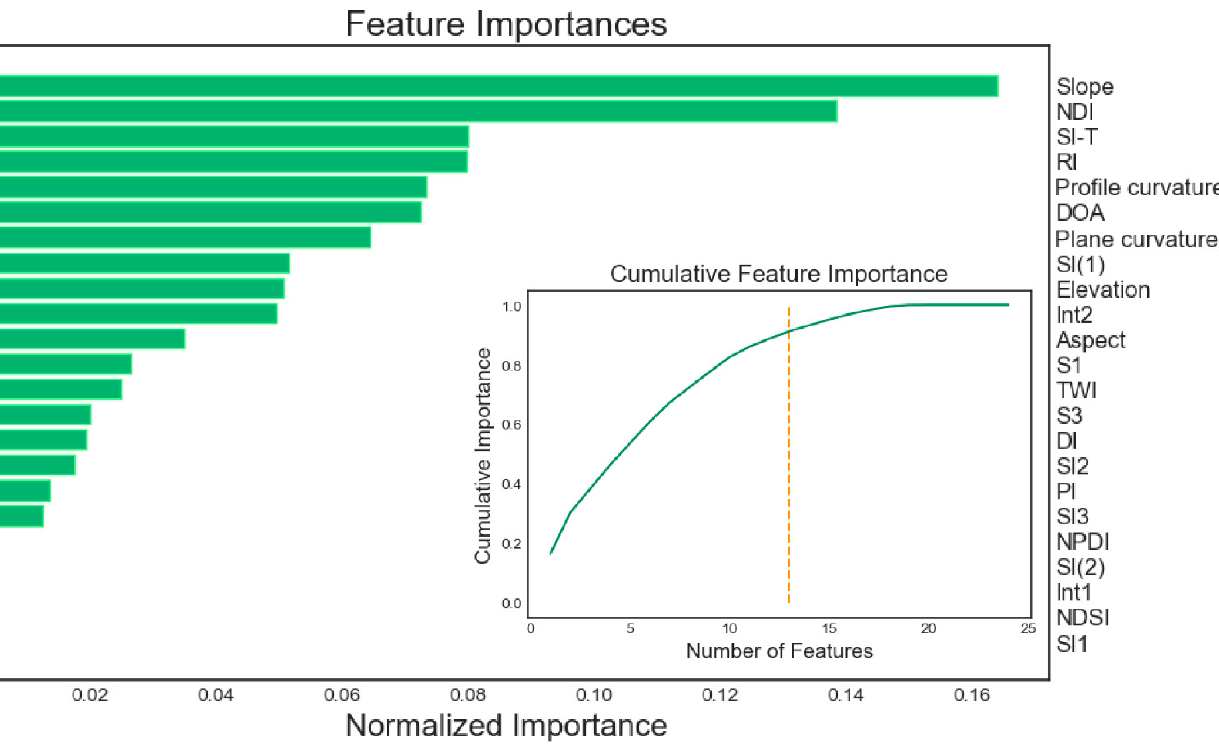
Figure 7. Feature importance of spectral index and topographic factors ranking using gradient boosting machine (GBM). Dotted vertical line representing cumulative feature importance reached 0.9 (90%).